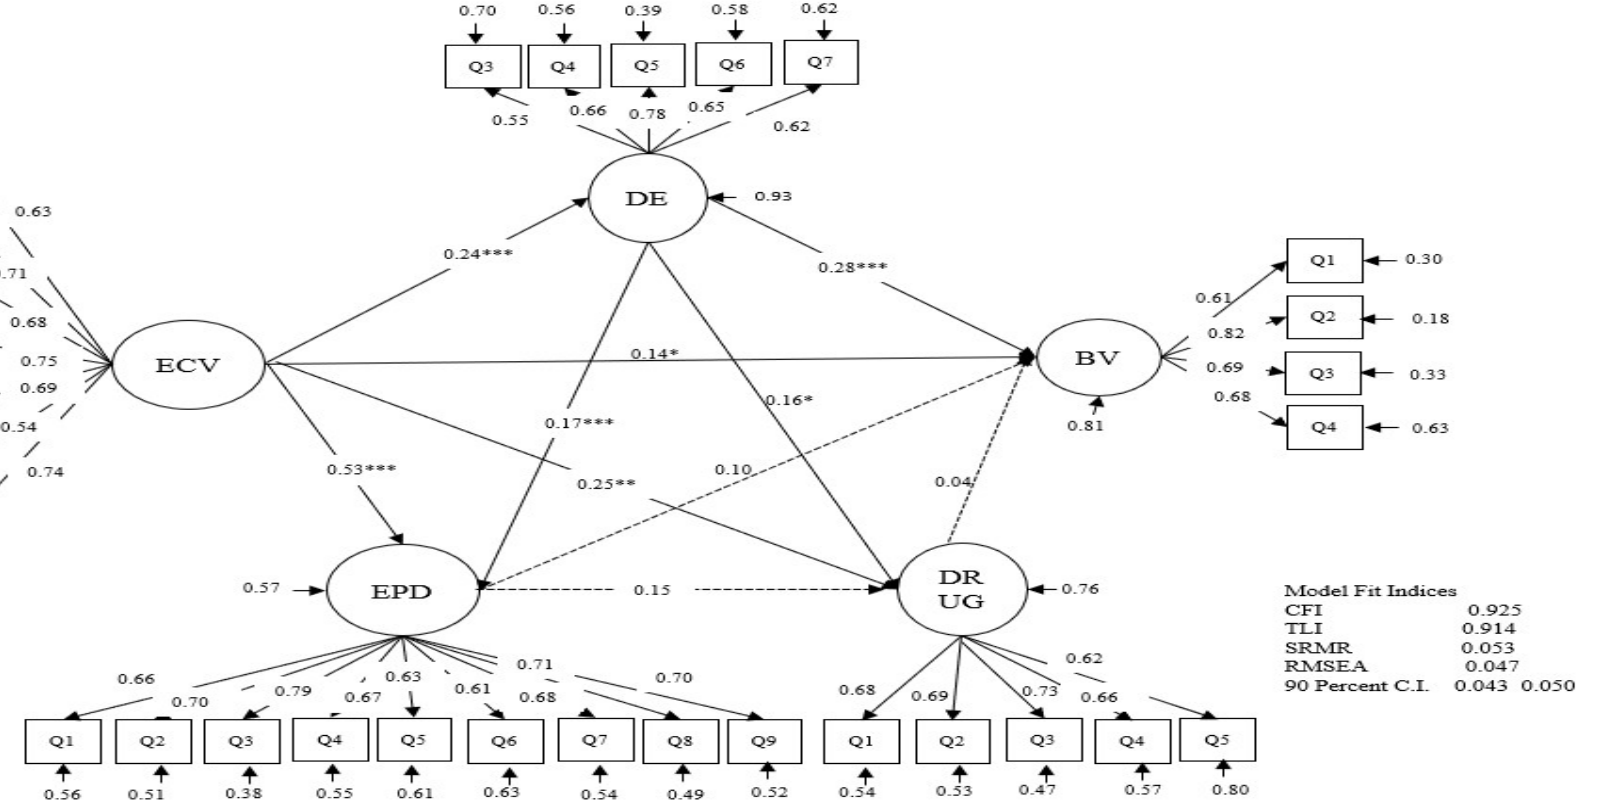
Figure 1. Estimates of the Pathways from Exposure to Community Violence to Bullying Victimization. Note . BV = bullying victimization, ECV = Exposure to community violence, EPD = Exposure to peer delinquency, DE = Depression, DRUG = Drug use. The asterisk mark is only displayed for the pathways between the study variables. The effects of the covariates on the variables were omitted in the figure. Please refer to the Measures section for indicators (Q1~Q9) of the latent variables. * p < 0.05; ** p < 0.01, *** p < 0.001.